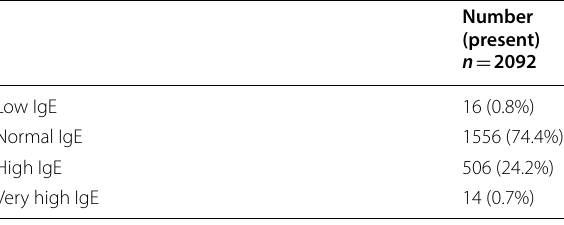
Table 1 IgE level categories of the study